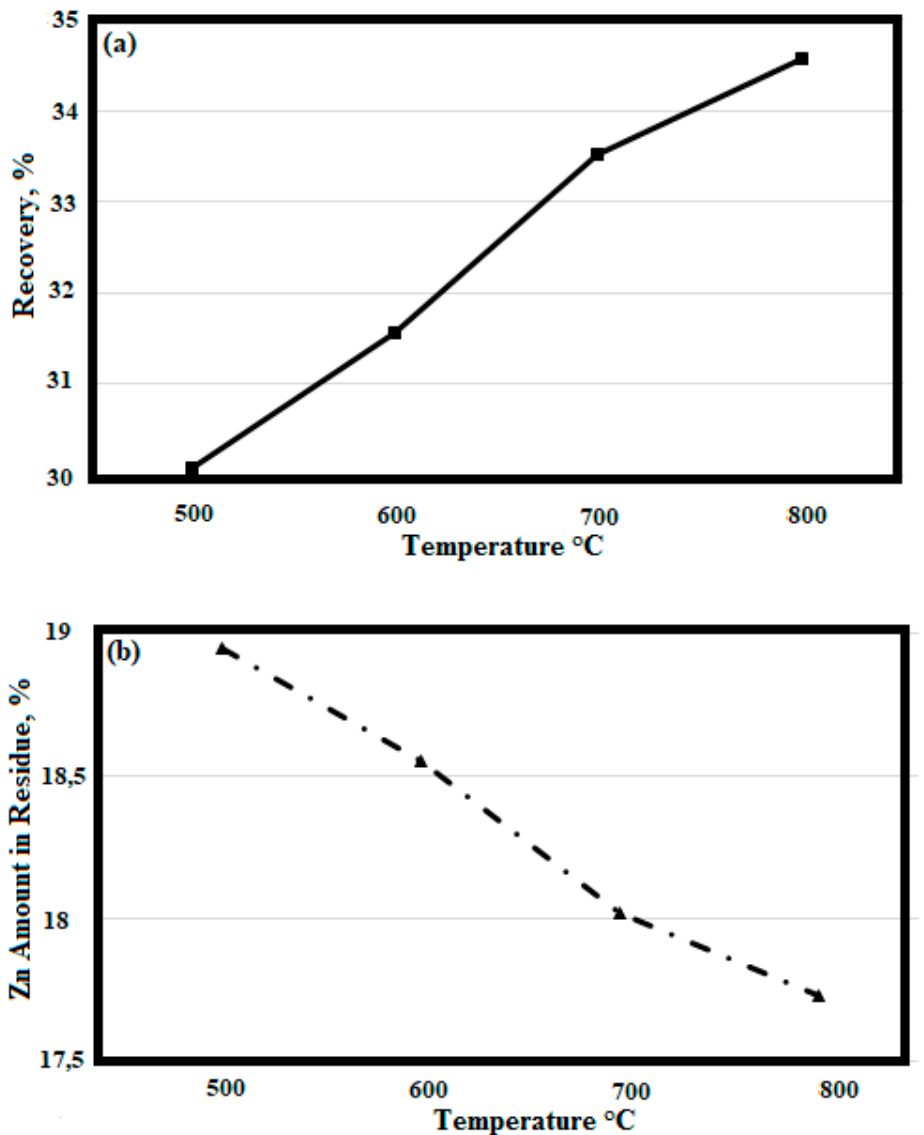
Figure 8. ( a ) Zn recovery, ( b ) Zn amount in residue with lignite (1 h, 10 Pa vacuum, various